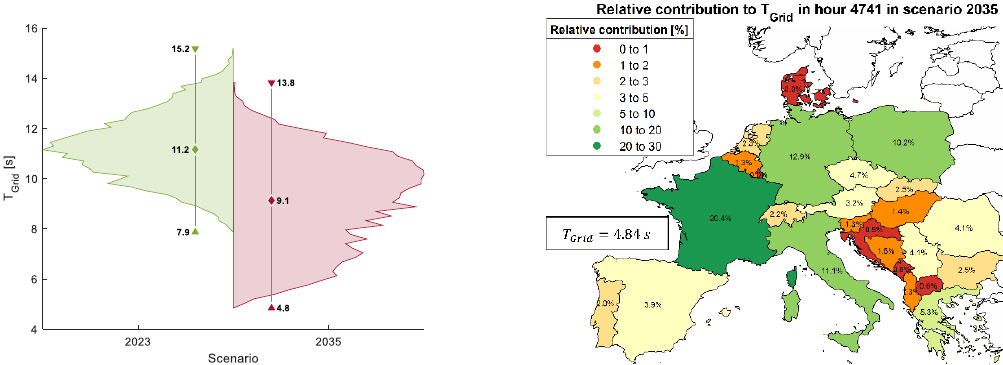
Figure 14. T grid for scenarios 2023 and 2035 ( left ) and each of the continental Europe (CE) region countries’ contribution to system inertia for hour 4741 with lowest overall system inertia ( right ).